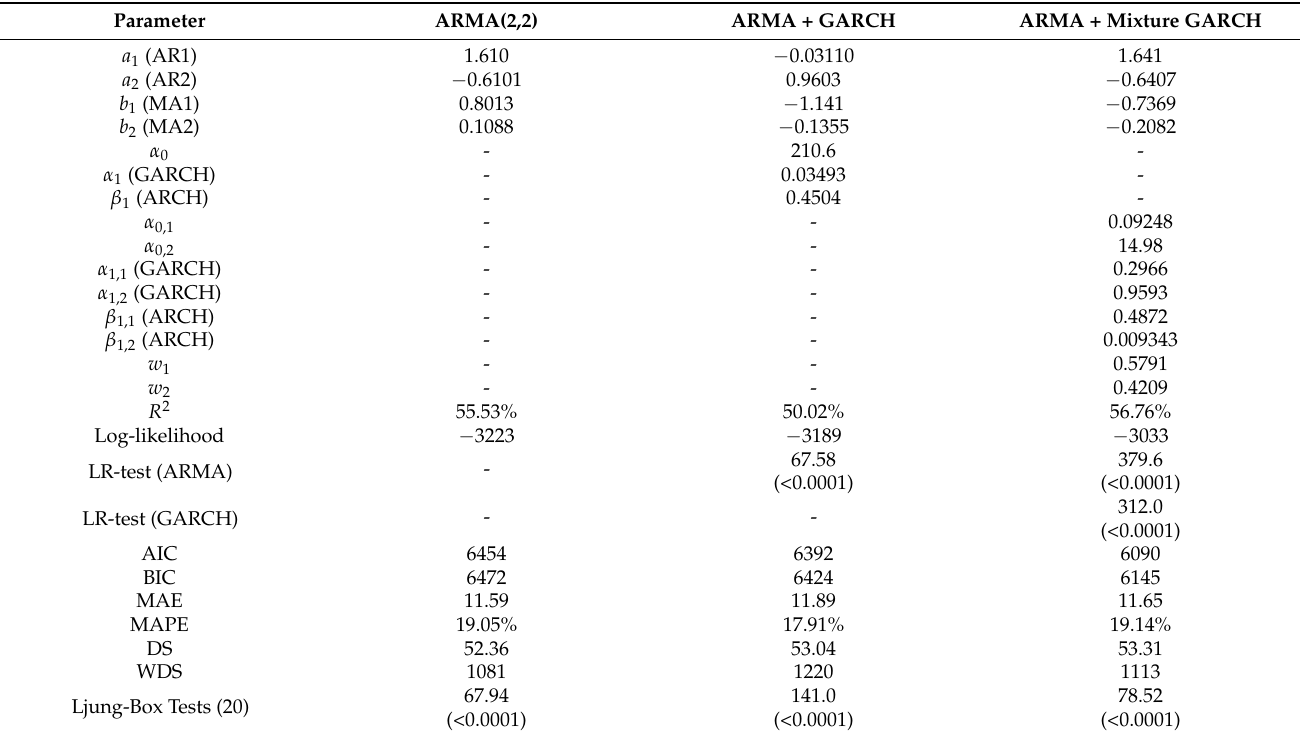
Table 7. Estimated parameters and performance measures for the first electricity price sample.